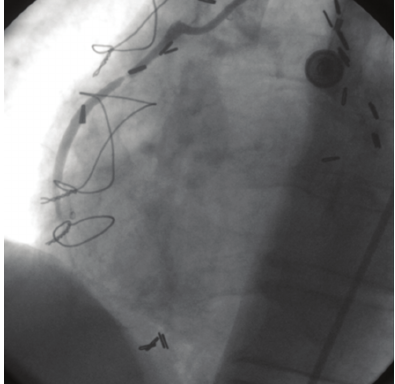
Figure 1: Saphen vein arteriogram showing 95% stenosis.